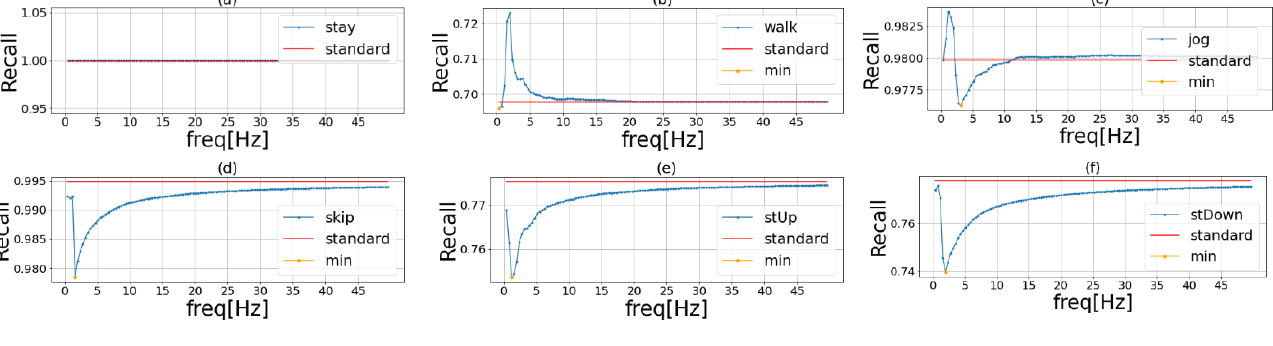
Figure 3. Important frequency of each activity in HASC. The blue line in the graph shows the recognition accuracy when we masked the frequencies of the original sensor data in order. The red line shows the recognition accuracy when we used the original data. The yellow point is the lowest recognition accuracy when we use the frequency masked data. Each activity is ( a ) stay, ( b ) walk, ( c ) jog, ( d ) skip, ( e ) stUp, and ( f ) stDown. Table 1. Important frequency of each activity in HASC.